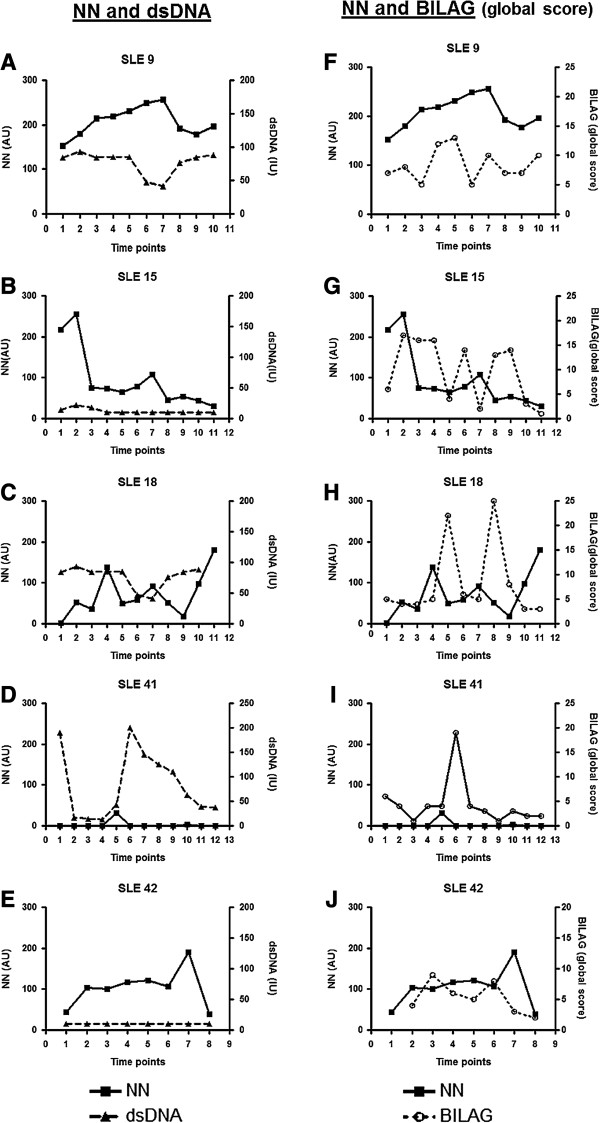
Variation of NN and anti-dsDNA levels and global BILAG scores over time. This figure shows the variation of serum NN levels over time in five patients compared to anti-dsDNA levels (A-E) and global BILAG scores (F-J). anti-dsDNA, anti-double stranded DNA antibodies; BILAG, British Isles Lupus Assessment Group; NN, nitrated nucleosomes.